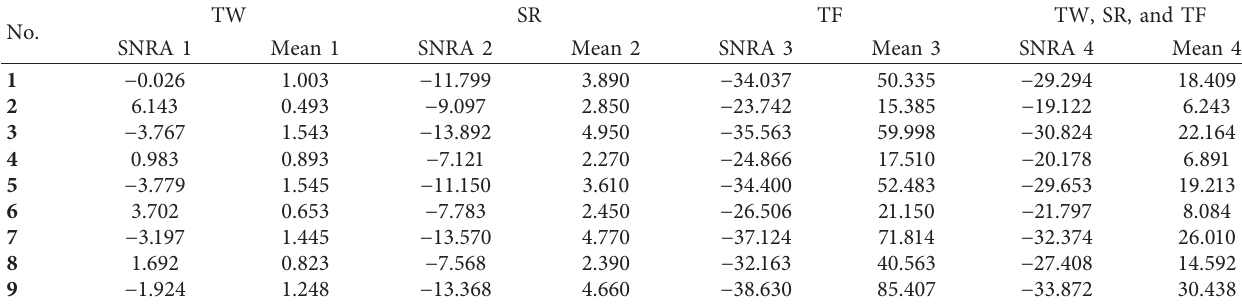
Table 8: Cumulative outcome based on the signal-to-noise ratio and means in each trails’ comparison. TW SR No.